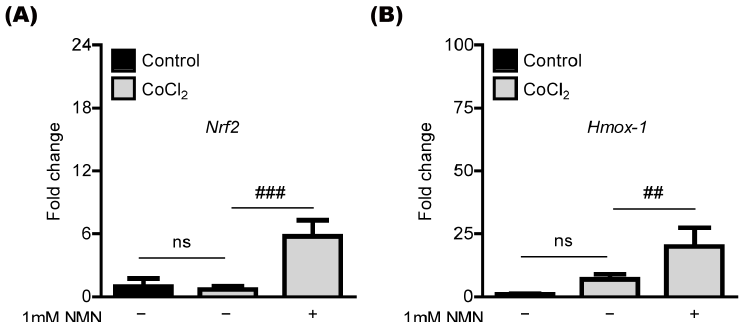
Figure 4. Antioxidant gene regulation by nicotinamide mononucleotide (NMN) treatment. ( A , B ) Quantitative analyses ( n = 5 per group) demonstrated that NMN treatment (6 h) increases mRNA expression in the antioxidant genes ( Nrf2 and Hmox-1 ) in 661W cells under 400 μ M CoCl 2 -induced oxidative stress conditions. ## p < 0.01 and ### p < 0.001. ns, not significant. The data were